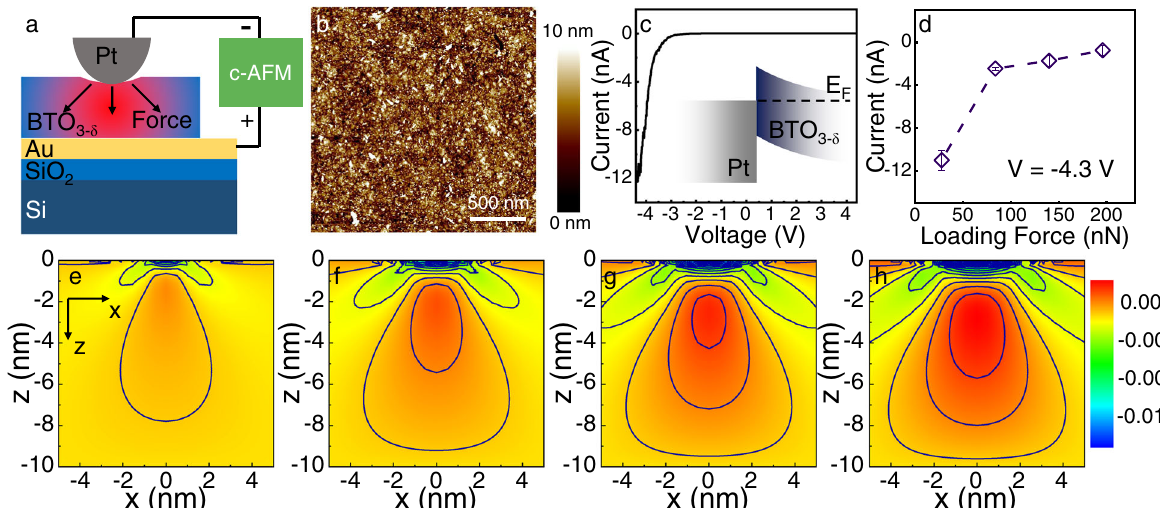
Fig. 5 Enhanced fl exoelectric properties of the BTO 3- δ membrane. a Illustration of the experimental con fi guration of the c-AFM test. b AFM image of the transferred BTO 3- δ fi lm. c I – V curve of the Pt/BTO 3- δ junction. d Evolution of the current as a function of loading force. e – h COMSOL FEM calculation with a tip-force model of the BTO 3- δ fi lm under applied force of 28 nN, 84 nN, 140 nN, and 196 nN, respectively. The colors of blue to red correspond to lower to higher strain values. The solid lines in the fi gures represent the equivalent strain value pro fi fi lm on graphene/Ge (011). The extracted OP lattice parameter of the 90-nm thick BTO 3- δ on PI is ~4.028 Å, larger than the as- grown one, which could result from the release/absence of strain in the as-grown fi lm due to the substrate clamping. The XRD pattern of BTO 3- δ on Au/Cr/SiO 2 /Si substrates shows similar single crystallinity of the BTO 3- δ fi lm, more details of which can be found in Fig. S17 in SI.